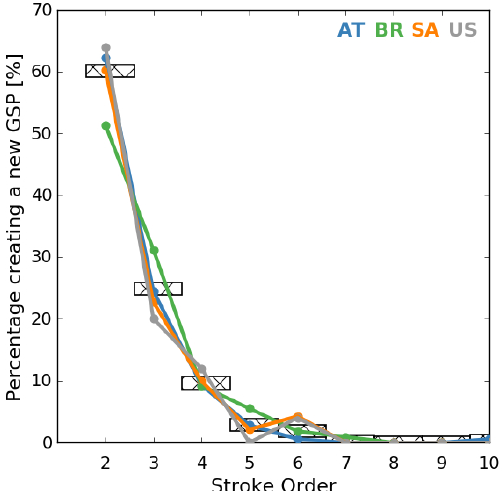
Figure 5. Distribution of the percentage of subsequent strokes cre- ating a new GSP as a function of stroke order. The shaded rectangles represent the result for the combined data sets.